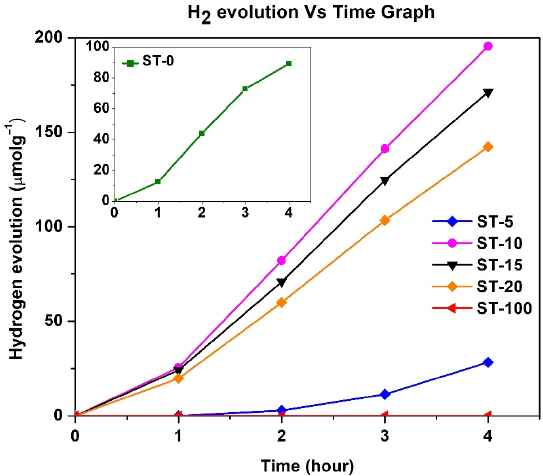
Figure 5. The amount of hydrogen evolved vs. time in the presence of pristine TiO 2 , SnS 2 , and SnS 2 /TiO 2 nanocomposite with different weight percentage (ST-5, ST-10, ST-15, and ST-20) in different time intervals. Table 1. A comparison of amount of hydrogen evolved with different transition metal